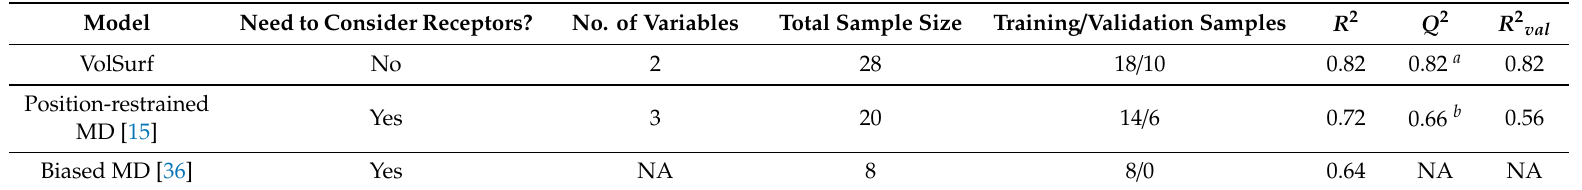
Table 5. Performance comparison among VolSurf, position-restrained and biased MD models.